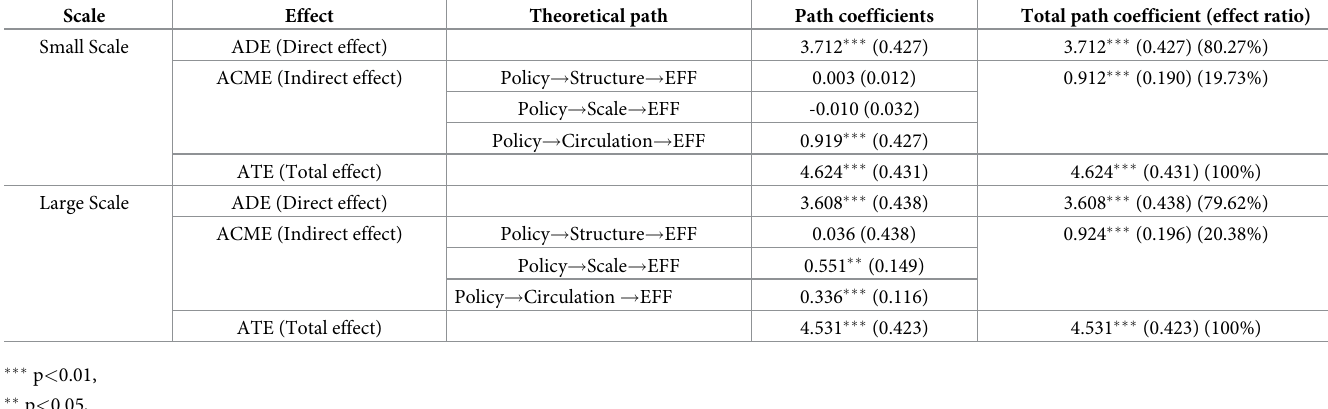
Table 7. Grassland ecological protection subsidy policy affects the results of path analysis of herder breeding technology efficiency: Based on different feeding